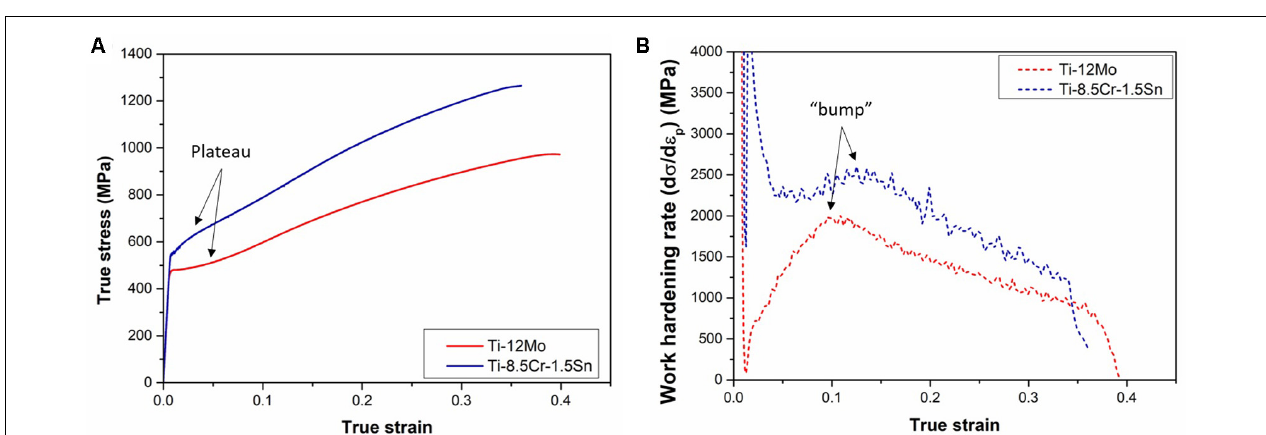
Frontiers in Materials |